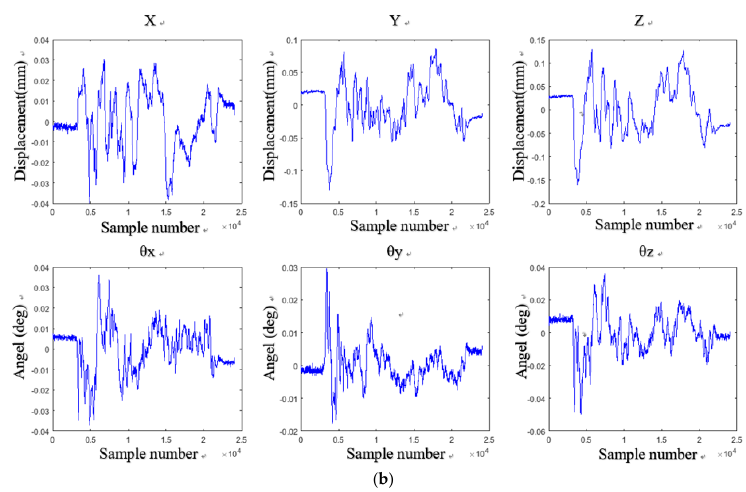
Figure 12. Six DOF measurement results and errors of the wafer stage at the second test: ( a ) six DOF measurement results; ( b ) six DOF measurement errors.